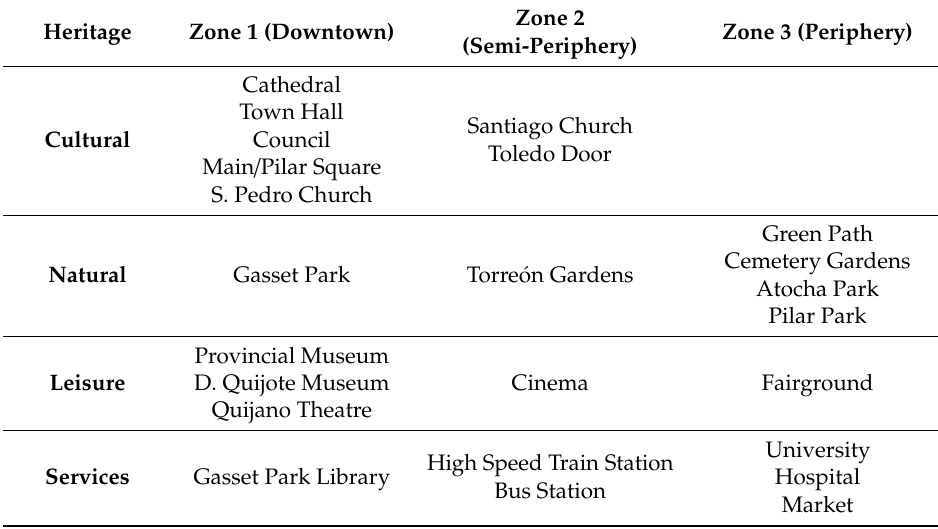
Table 1. Heritage distribution in city’s